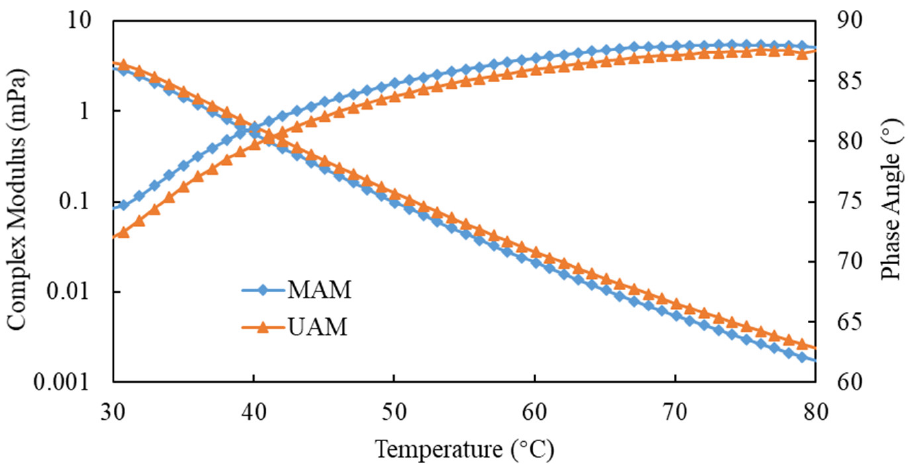
Figure 12. Rheological properties of asphalt mortar.